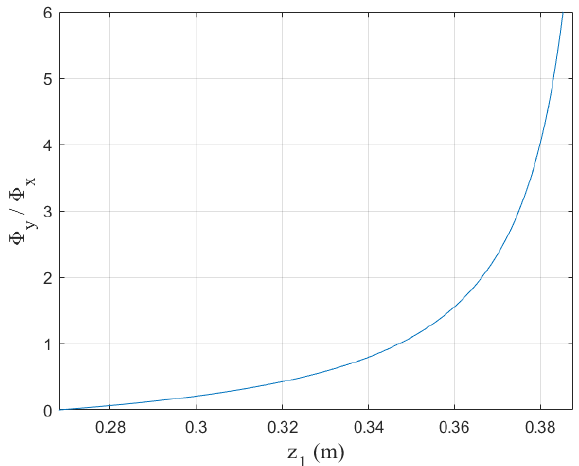
Figure 5. Evolution of the ellipticity ratio 𝛷 𝑦 /𝛷 𝑥 of the interferometric image versus the longitudinal position 𝑧 1 of the particle under observation.